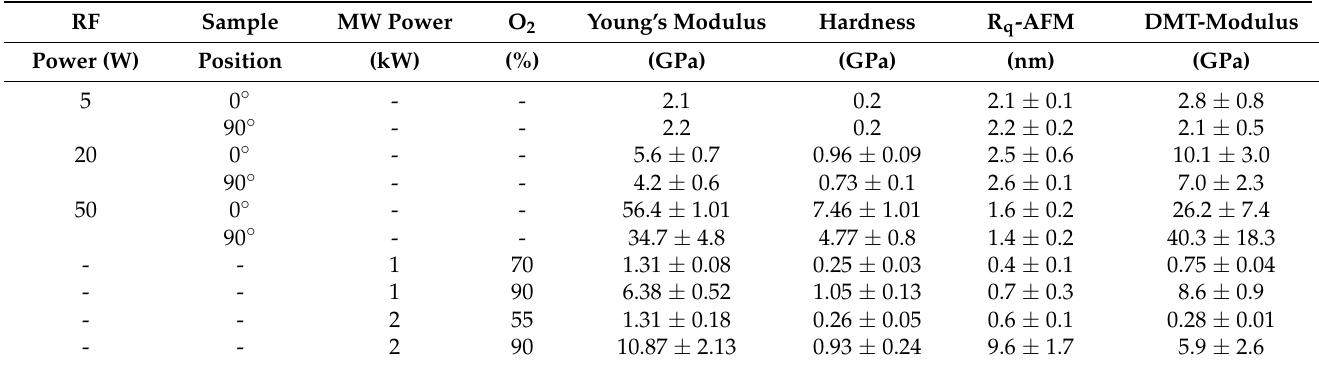
Table 4. Mechanical properties for RF and MW TMDSO films obtained via cube corner nanoindentation and AFM PF-QNM at varying powers and O 2